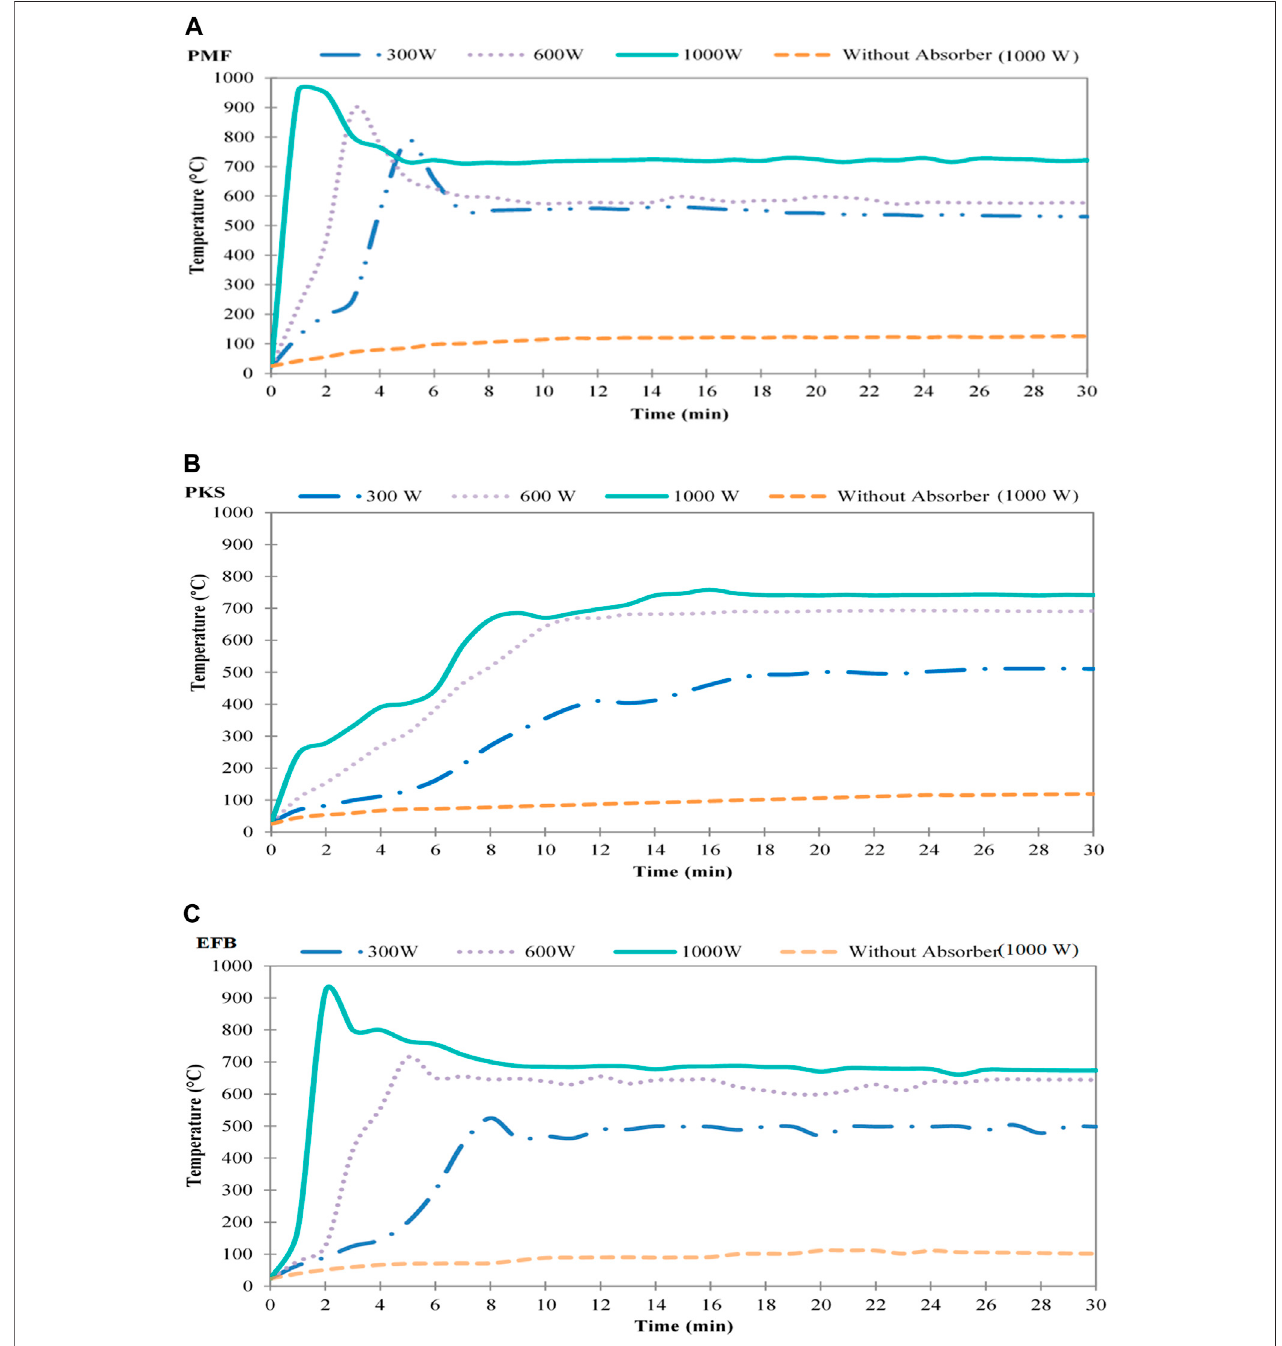
FIGURE 2 | Temperature pro fi le for microwave irradiation pyrolysis of (A) PMF, (B) PKS, and (C) EFB at different power level and at exposure time of 30 min.